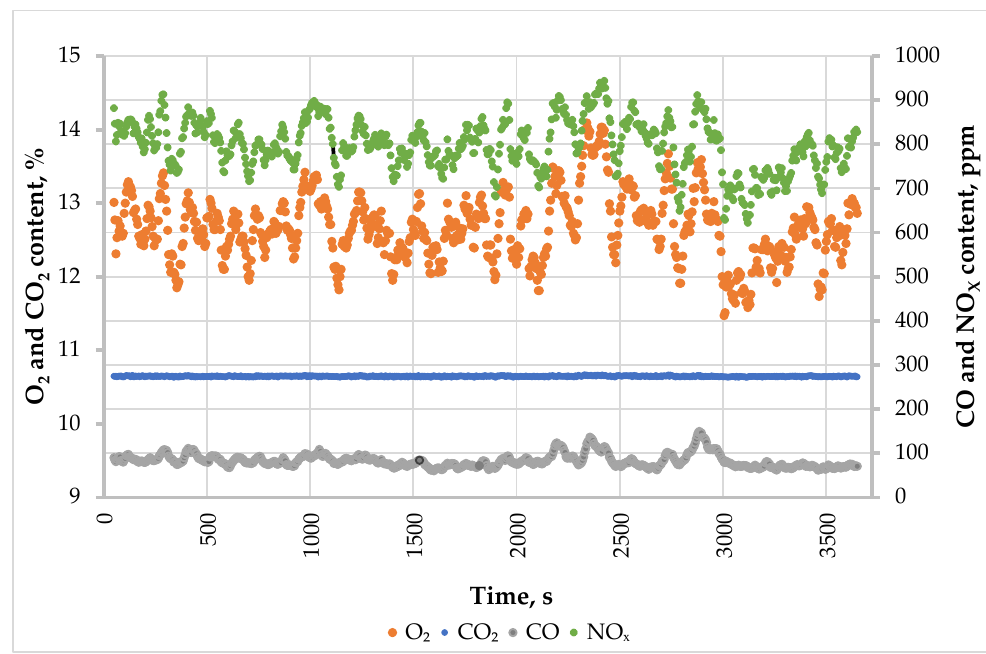
Figure 7. Chemical composition of flue gases during the combustion of wood-based waste pellets with additive Ad2.